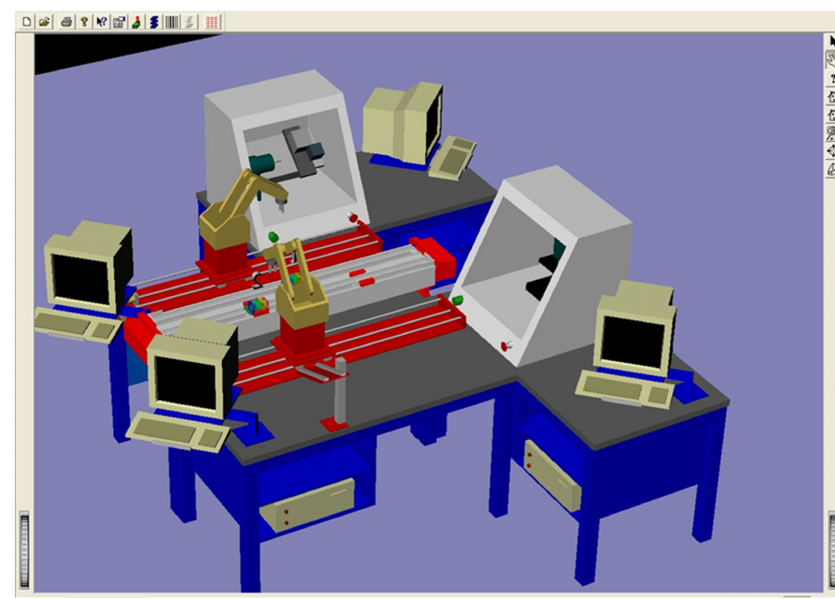
Figure 6. Created DT running real time production simulation.